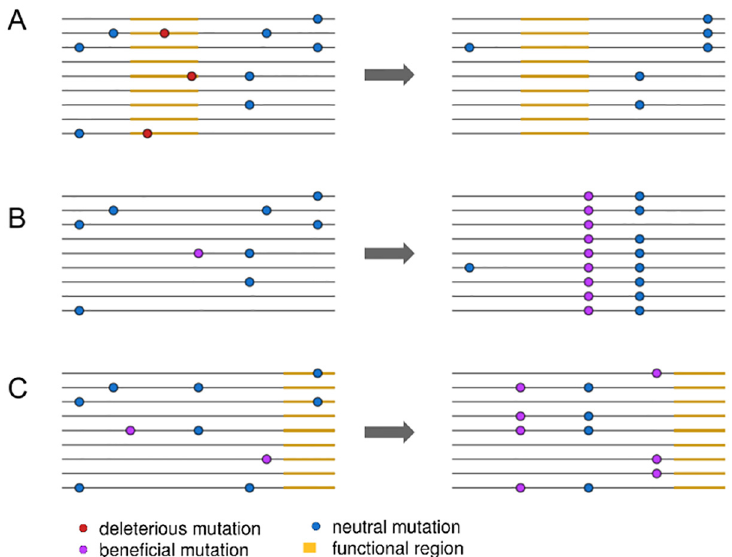
Fig 1. An illustration of three linked selection scenarios. In (A), the removal of deleterious mutations in a functional region, or background selection, reduces nearby linked diversity. In (B), the fixation of a new beneficial mutation by positive selection reduces nearby linked diversity in a process called a selective sweep. In (C), positive selection increases the frequency of two beneficial mutations, reducing diversity but not involving the fixation of any selected